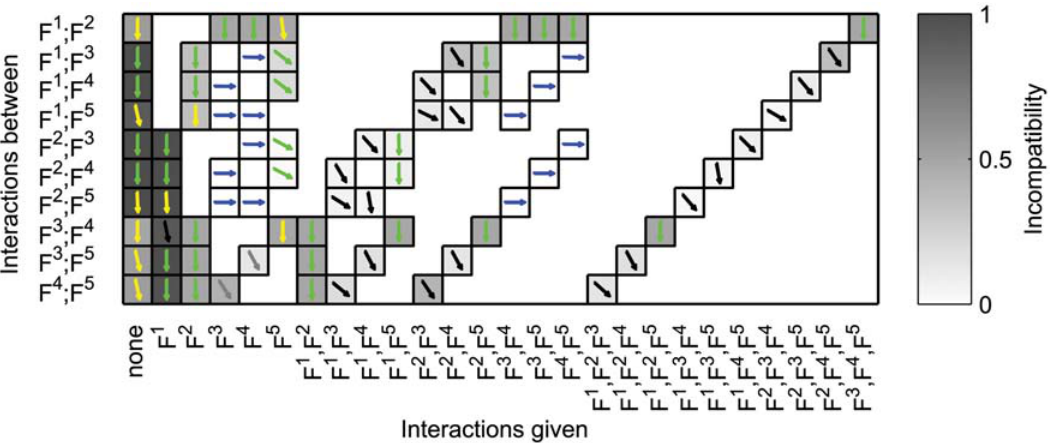
Fig 11. Compatibility of EFMs in the glycolytic pathway. The background shade of the matrix elements depict the steady-state incompatibility between the respective functionalities on the y-axis, given the functionalities on the x-axis, at a mixed flow glucose concentration of 10 mM (for notational convenience, dependencies on F 0 were assumed). For example, the shade of the element on the second row and twelfth column depicts I ( F 1 ; F 3 j F 2 , F 4 ). The direction of the arrows depict the steady-state cooperativity between the respective elements, with straight upwards corresponding to cooperativity equal one, straight downwards equal minus one, and horizontal equal zero. Finally, the colour of the arrows provides further information about the interaction: (black) the sum of both conditioned functionalities alone as well as the mutual dynamics are stable, and the overall network is stable; (grey) same as black, only the overall network is unstable. Thus, the instability is in a layer the two functionalities are conditioned on; (green) the sum and the mutual dynamics are unstable and the overall network stable. The interaction stabilises the network; (yellow) same as green, but the overall network is unstable. Typical when the interaction only stabilises some of the species, or if the speed of divergence is smaller; (blue) the sum is unstable and the mutual dynamics and the overall network are stable. Typical if the instability was in a layer the functionalities are conditioned on, and one of the functionalities stabilises the network.